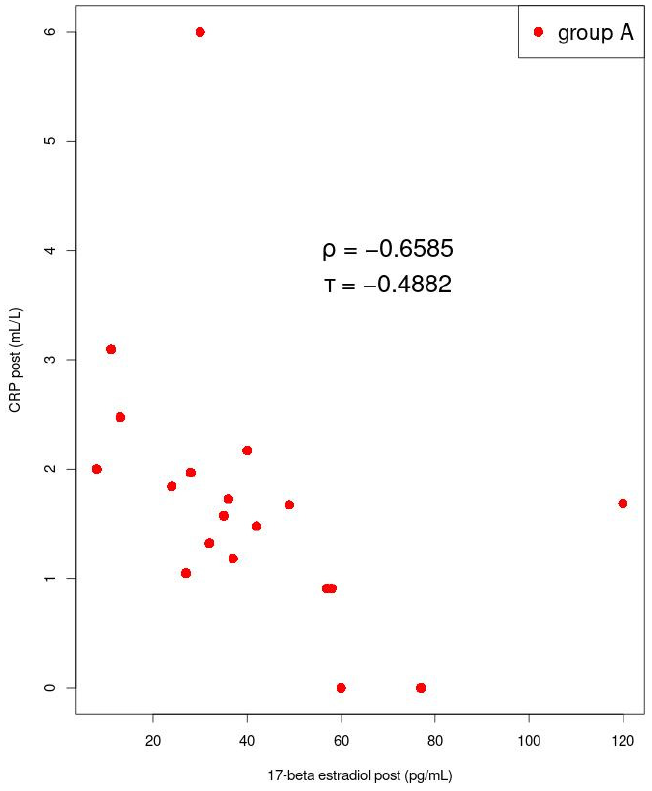
Figure 7. Correlation between 17-beta estradiol and CRP. Kendall’s tau ( τ ) values and Spearman’s rank correlation rho ( ρ ) are shown. The determined values of the coefficients are statistically signif- icant.